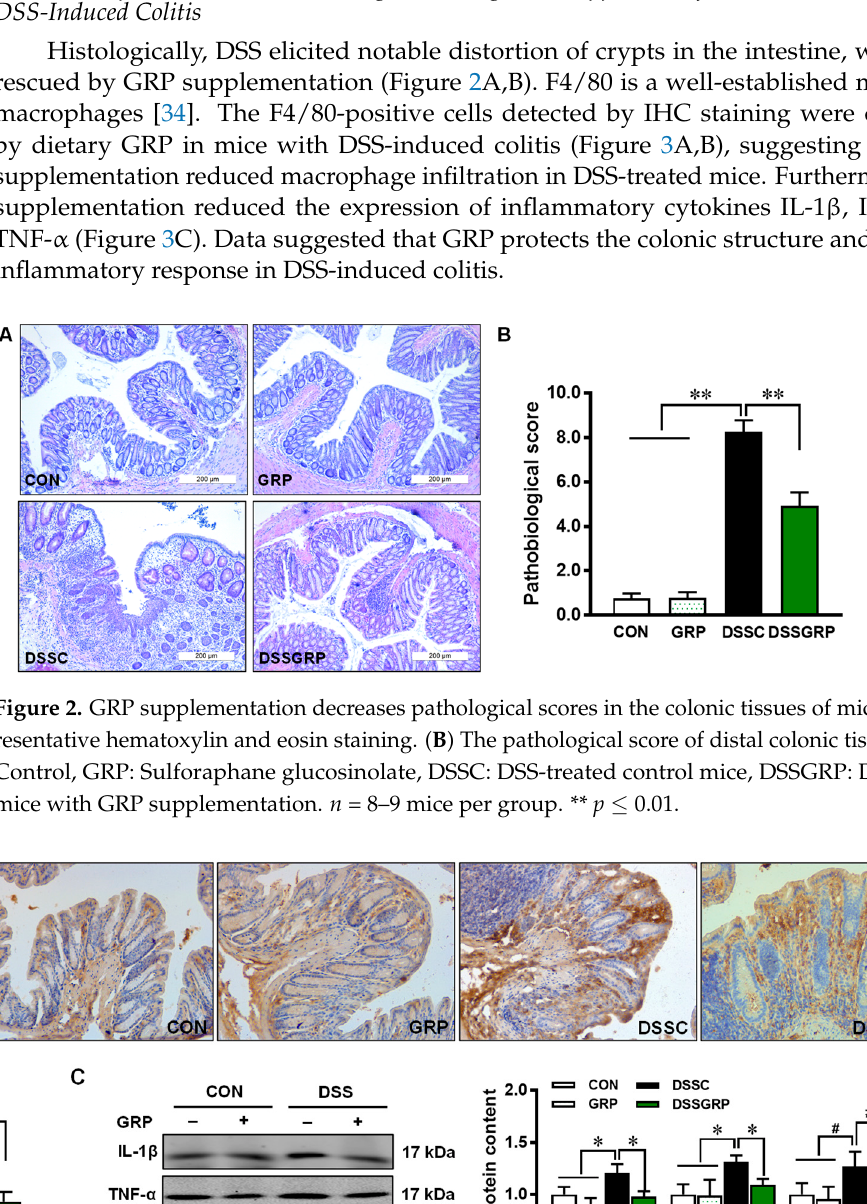
Figure 1. GRP supplementation suppresses disease symptoms in DSS-induced colitis mice. ( A ) Body weight loss. ( B ) Blood in stool. ( C ) Fecal consistency. (D) Disease activity index. ( E ) The representa- tive images of the dissected colon. ( F ) Colon length. CON: Control, GRP: Sulforaphane glucosin- olate, DSSC: DSS-treated control mice, DSSGRP: DSS-treated mice with GRP supplementation. Mean ± SEM, n = 10. # p < 0.10, * p ≤ 0.05, ** p ≤ 0.01.